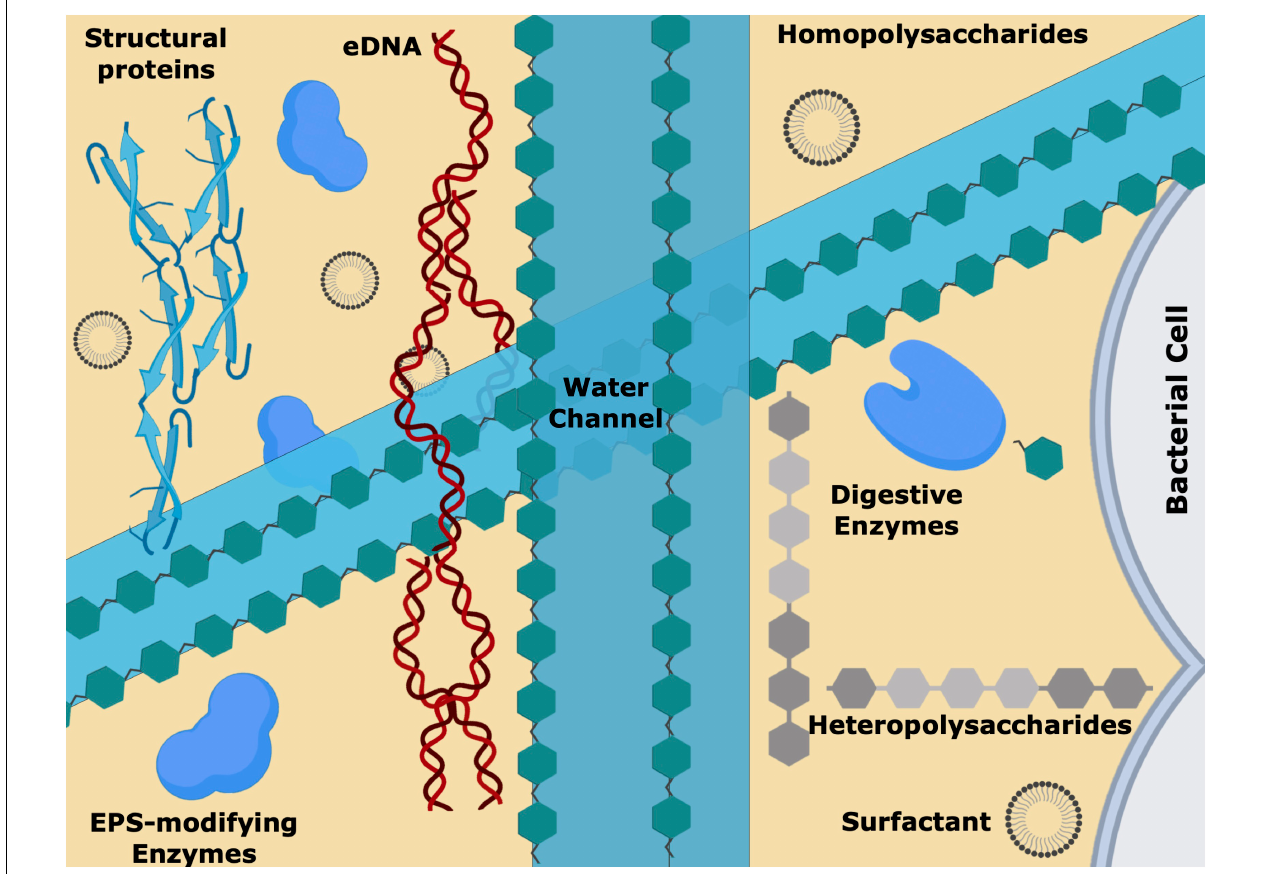
FIGURE 3 | Schematic representation of the extracellular polymeric substances (EPS) matrix, showing the biofilm water channels, surfactants, the short and long sugar chains, the different proteins/enzymes and extracellular DNA (eDNA). This intricate 3D net of biomolecules is responsible for the chemical/physical and mechanical characteristics of the biofilm, allowing cell–cell communication, nutrients/gas diffusion and antimicrobial tolerance.